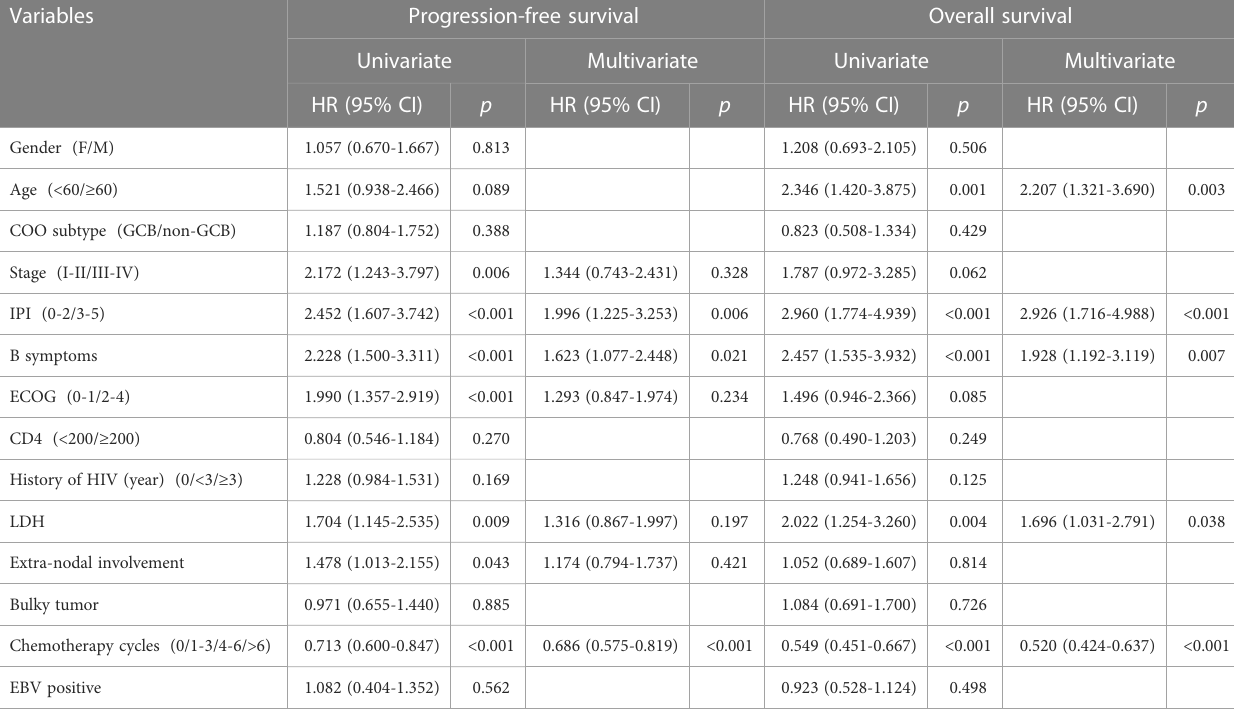
TABLE 3 Prognostic factor analysis for progression free survival and overall survival.